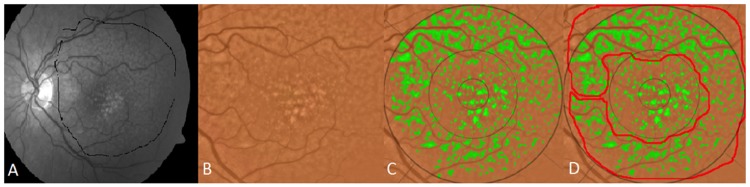
Segmentation of reticular pseudodrusen.A) original fundus photograph with large area containing both reticular macular disease (reticular pseudodrusen) and ordinary soft drusen outlined in black. The soft drusen are confined to the central macula. The reticular pseudodrusen extend to the arcades. B) original color fundus photo C) both reticular pseudodrusen and soft drusen are segmented (green) on the color photo within the area identified in A and within the superimposed Wisconsin grading template. D) The area of reticular macular disease is separately enclosed in red, and was excluded from drusen measurements.